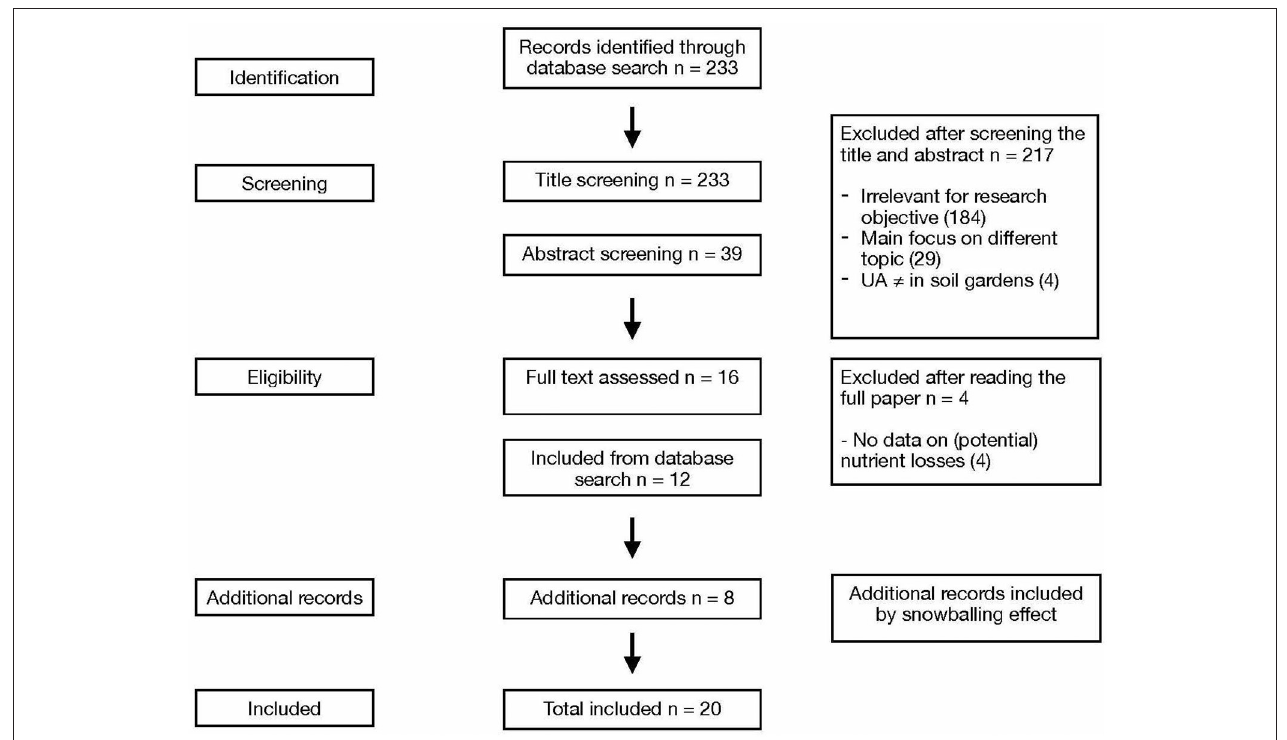
FIGURE 1 | Number of studies captured in searches and removed at different stages of the selection